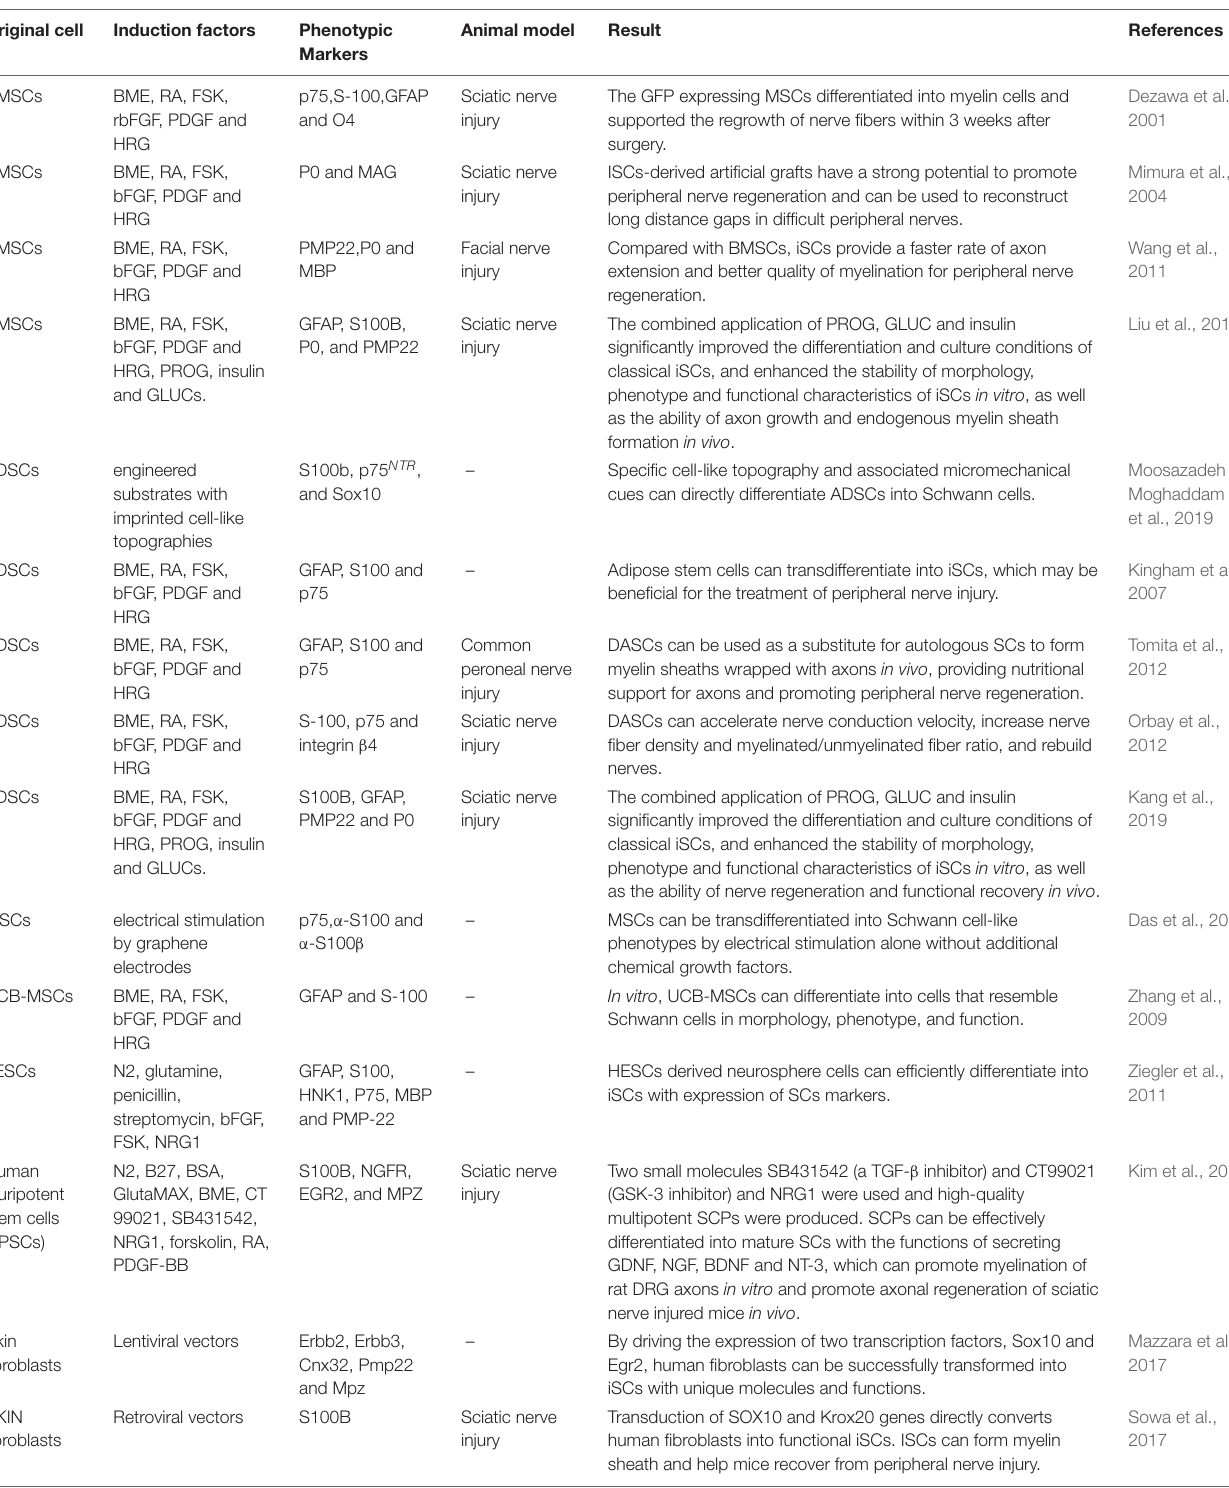
TABLE 2 | The methods used in recent years to reprogram cells from different sources into iSCs are